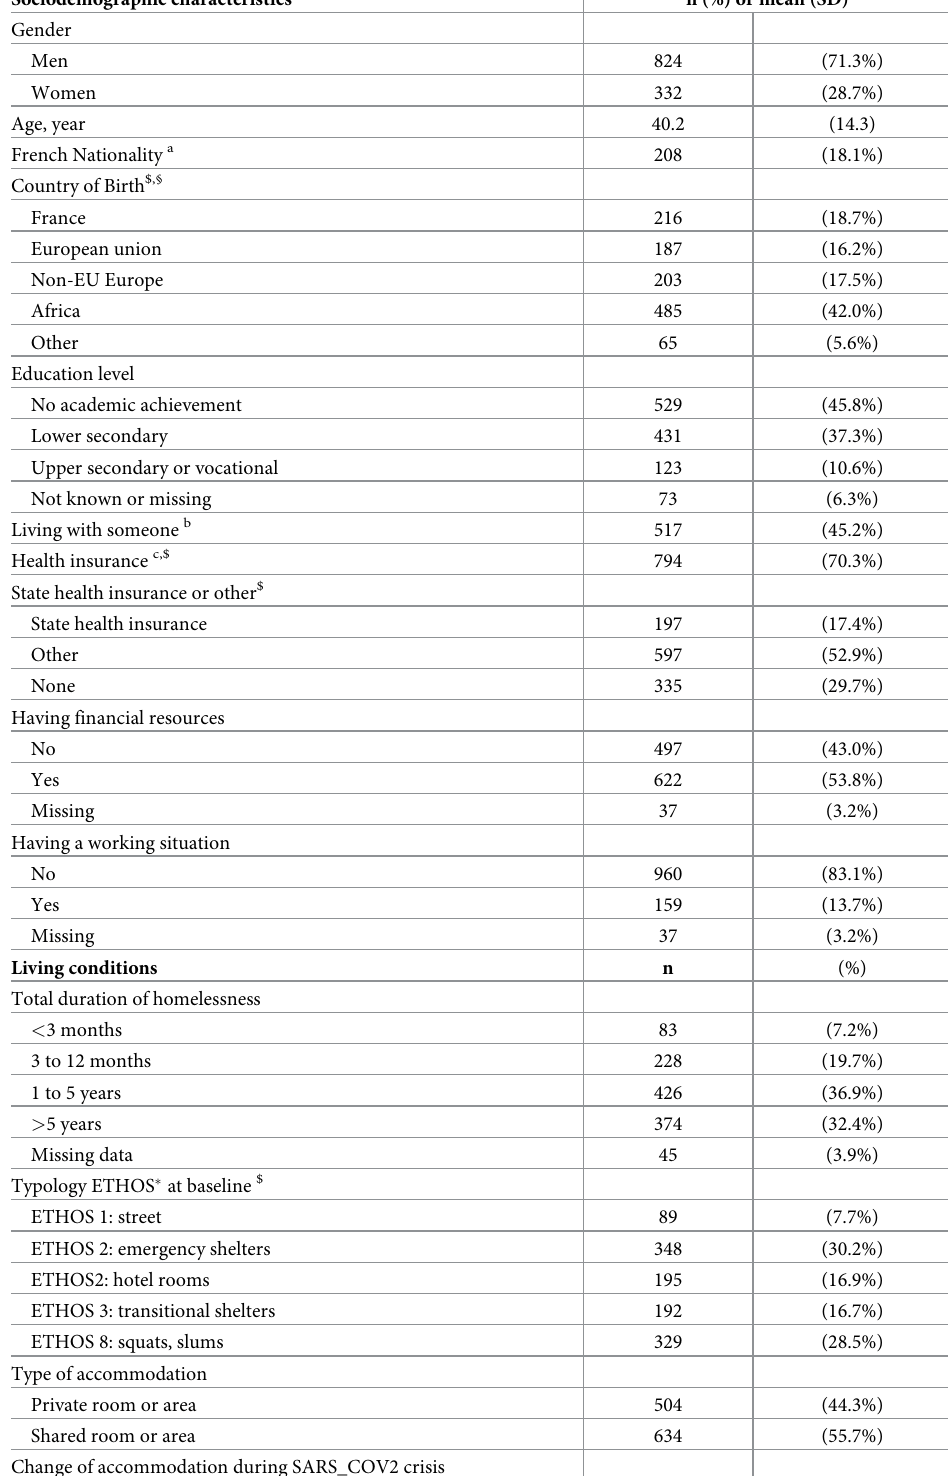
Table 1. Sociodemographic characteristics of the study population (n =